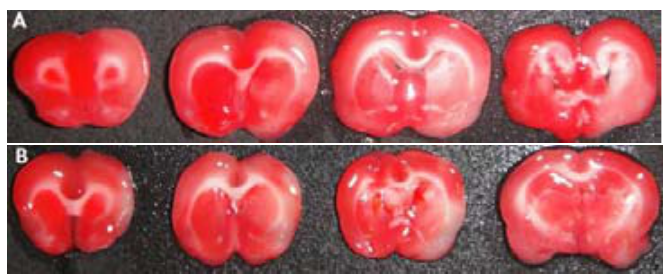
FIGURE 2 - Brain slices stained with TTC to visualize lesions. TTC- stained brain slices from PBS injection ( A ) and following intracerebral delivery of mESC after MCAO are shown in B, respectively.